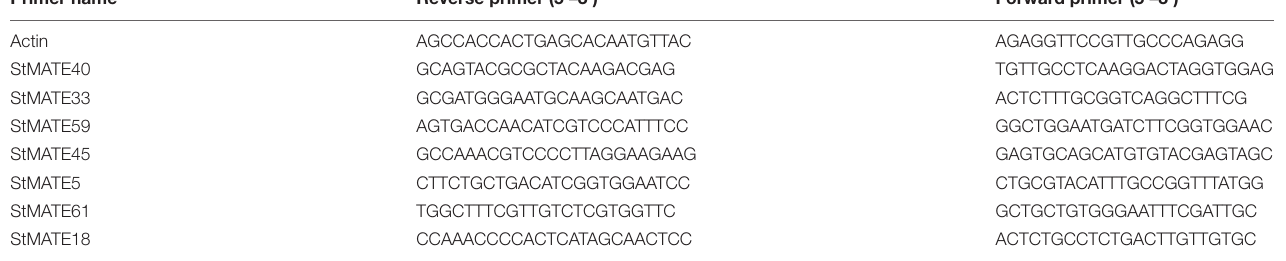
TABLE 2 | Primer design of eight genes.